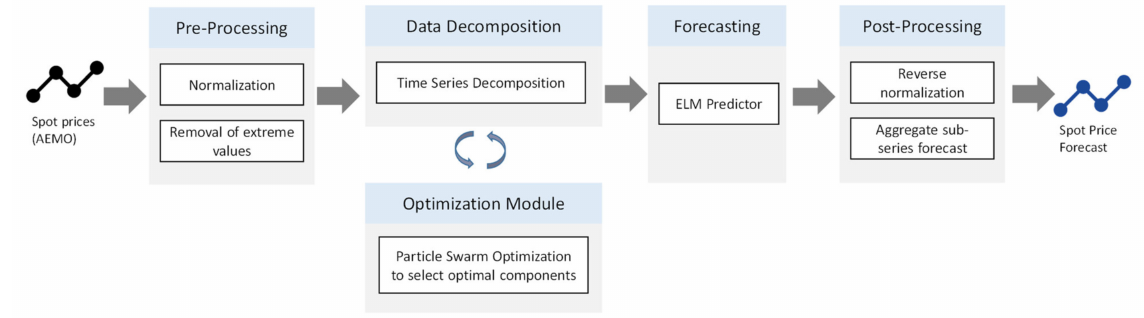
Figure 1. The Proposed Method-Robust Intelligent Price Prediction in Real-time